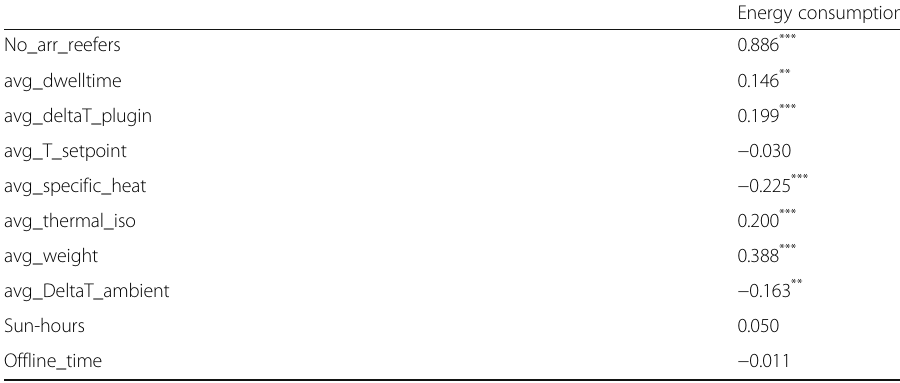
Table 6 Correlation of the factors to the energy consumption